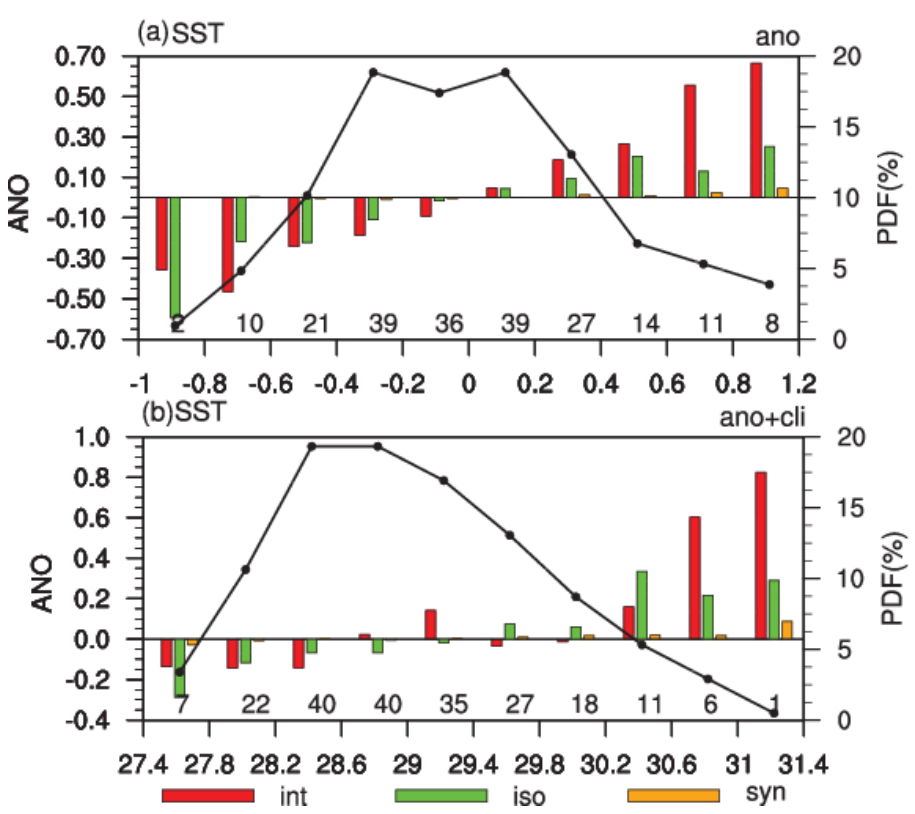
Figure 2. Distribution of daily anomalies of ( a ) SST ( ° C) associated with the 207 TCs on interannual (red bar), intraseasonal (green bar), and synoptic (orange bar) time scales during AMJJASOND in 1979–2020. ( b ) The same as ( a ) except that the bins are grouped based on total SST. The solid line indicates the probability density function of TC formation (scale at right). The digit number above the x-axis indicates the TC formation number in each bin.